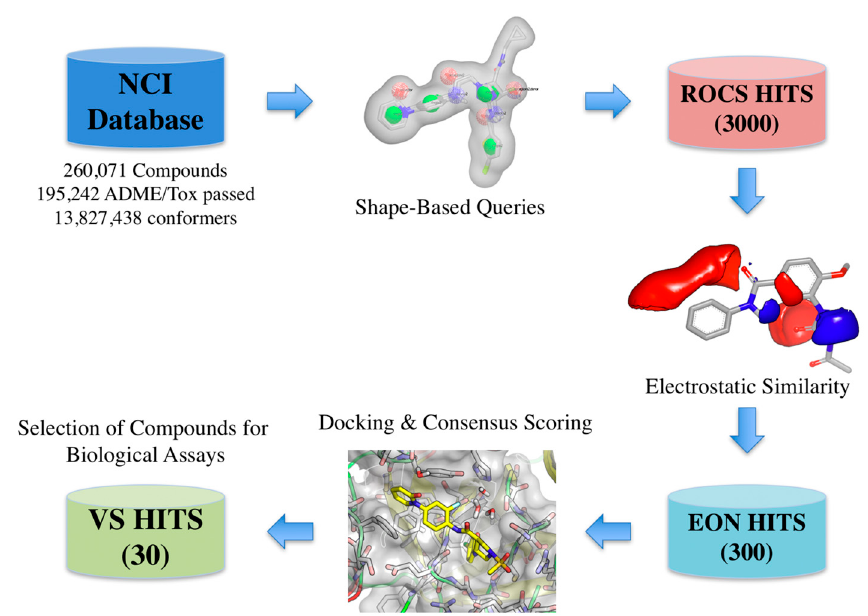
Figure 4. Schematic overview of the virtual screening workflow and the procedure used for selecting the virtual screening hits whose bioactivity was experimentally tested. The number of compounds that passed each step and the programs used are shown. From an initial set of near 260,000 compounds, 300 compounds were identified as putative FXa inhibitors by the virtual screening workflow. Thirty of these compounds were selected for in vitro testing.